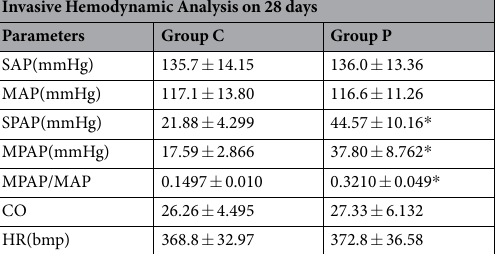
Table 1. Invasive hemodynamic analysis of rats in the PAH and control groups. n = 6, * Compare with Group C, p < 0.05.